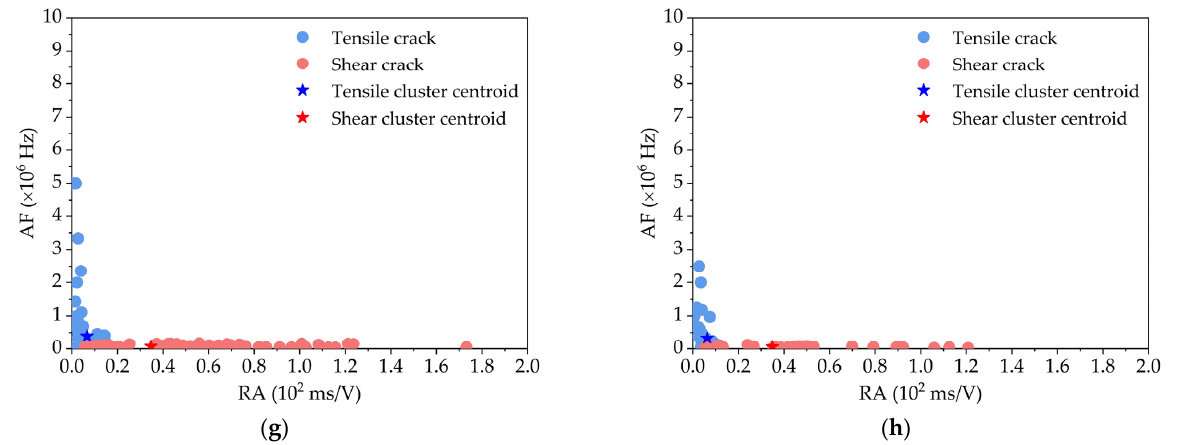
Figure 8. Compressive fracture mode classification based on the AE indirect parameters for asphalt mixture subjected to F-T conditions: ( a ) 0 cycle; ( b ) 3 cycles; ( c ) 6 cycles; ( d ) 9 cycles; ( e ) 12 cycles; ( f ) 15 cycle; ( g ) 18 cycles; ( h ) 21 cycles.